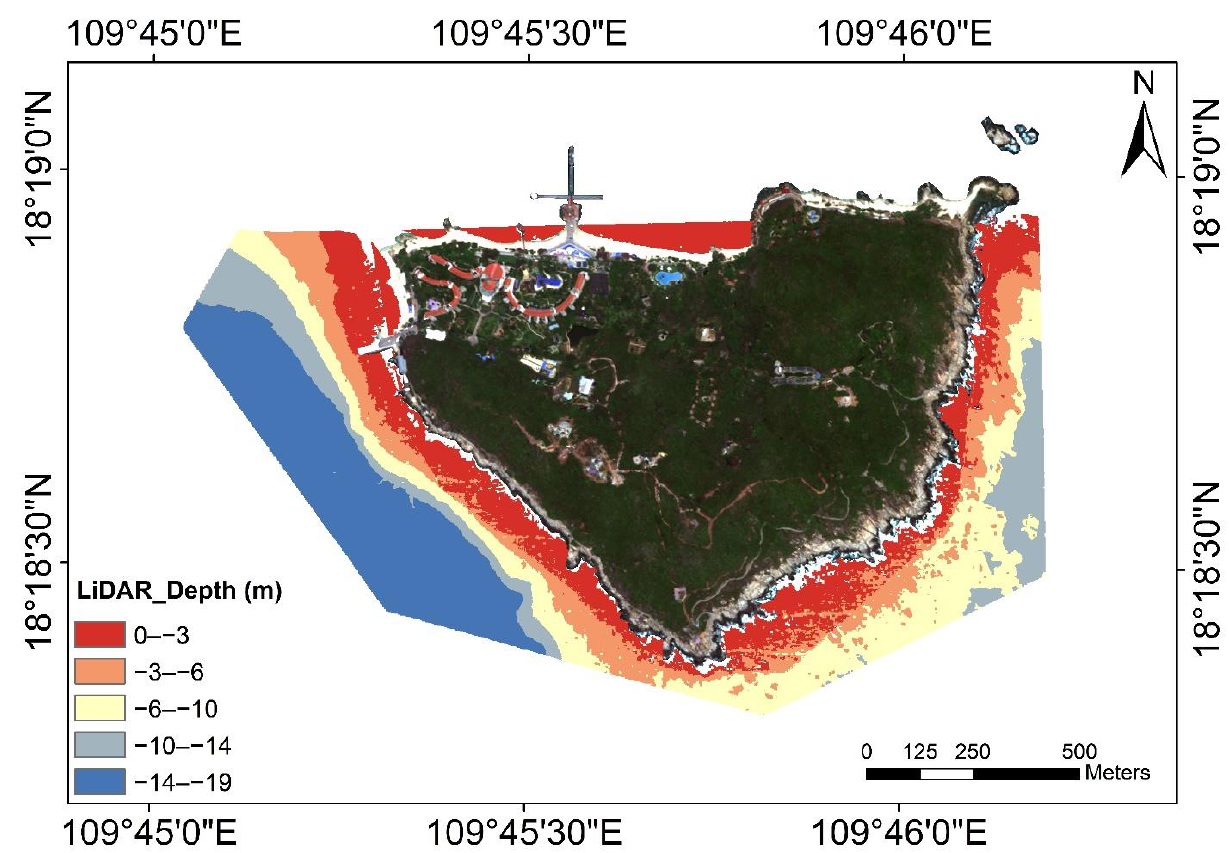
Figure 2. Airborne LiDAR elevation data of Wuzhizhou Island. Table 2. Airborne LiDAR point cloud statistics. Units: m.